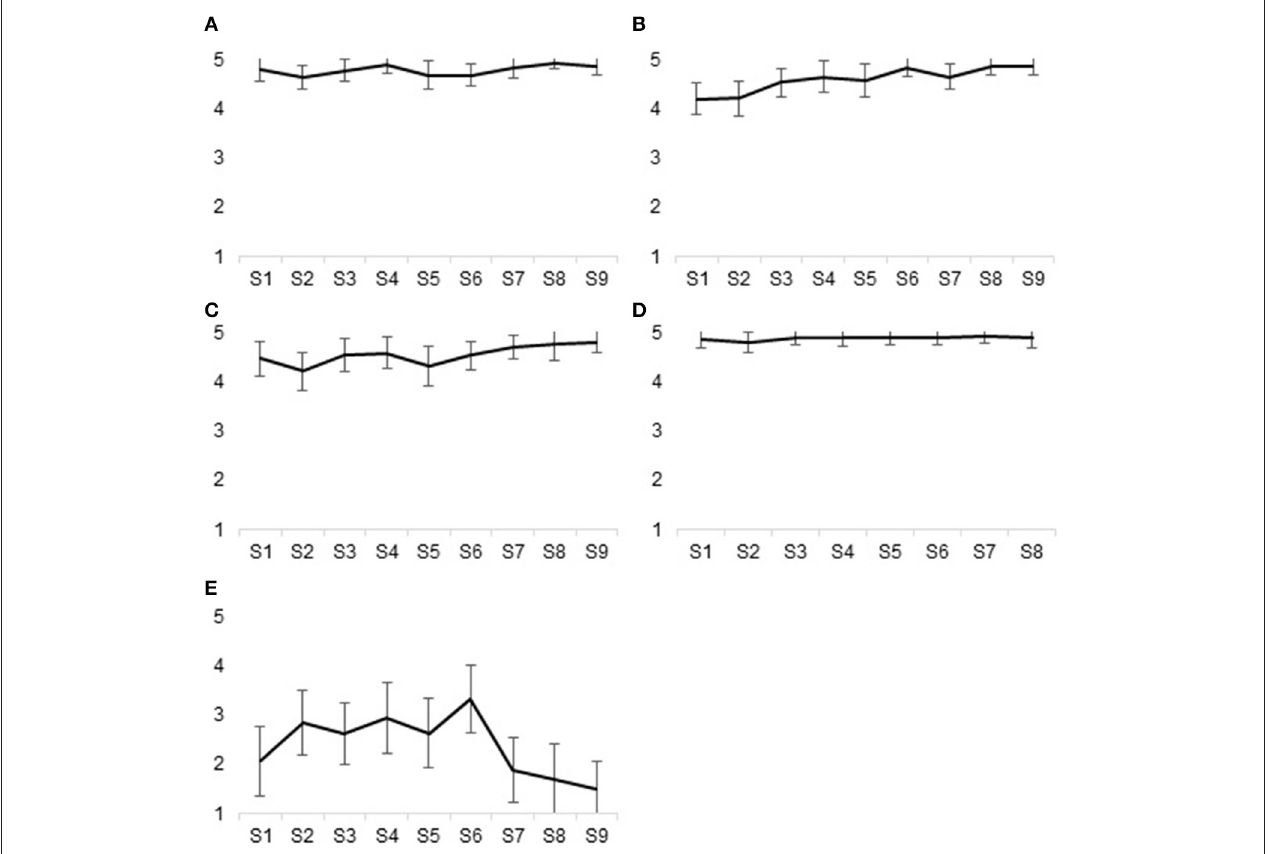
FIGURE 3 | Level of satisfaction reported after each session of the program according to five indicators. Thirty pregnant women who participated in the program evaluated to what extent they considered each of the nine sessions to be useful, to be informative, to stimulate new insights, to be motivating, and to be emotionally challenging using a five-point Likert scale ranging from 1 (Totally disagree) to 5 (Totally agree). Length of the error bars represent the 95% confidence interval for the mean. (A) Useful, (B) Informative, (C) New insights, (D) Motivating, (E) Emotionally challenging.